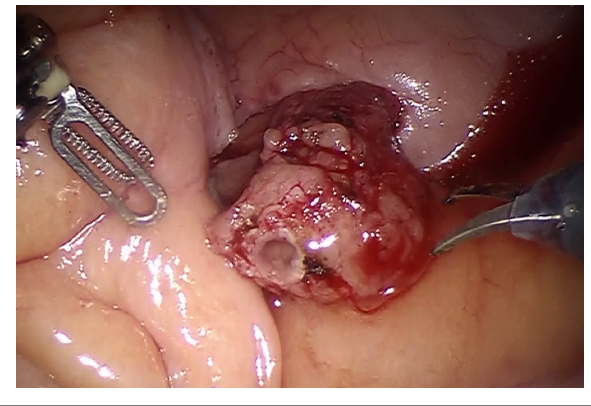
Figure 3. Transected distal ureteric end.